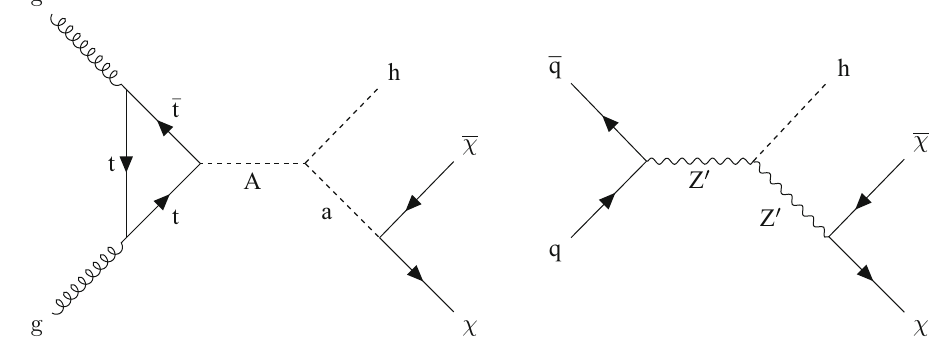
Fig. 1 Feynman diagrams for the 2HDM+a model (left) and the baryonic Z (cid:3) model (right). In both models, the scalar h can be identified with the observed 125GeV Higgs